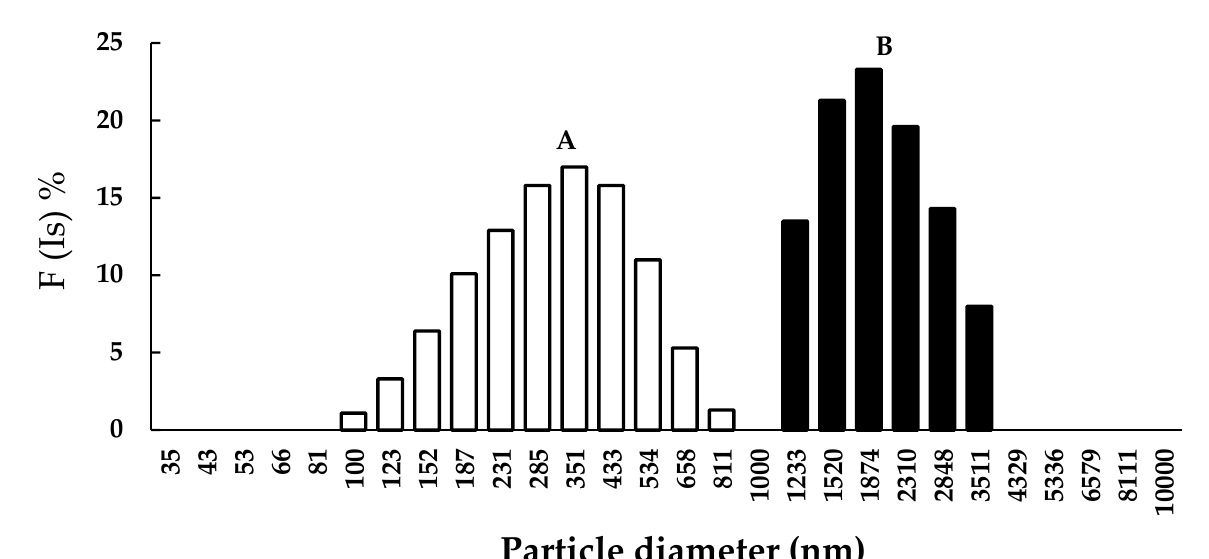
Figure 2. Particle diameter, nm (CKR12-PLGA is indicated by A; CKR12-PLGA-MCZ is indicated by B).